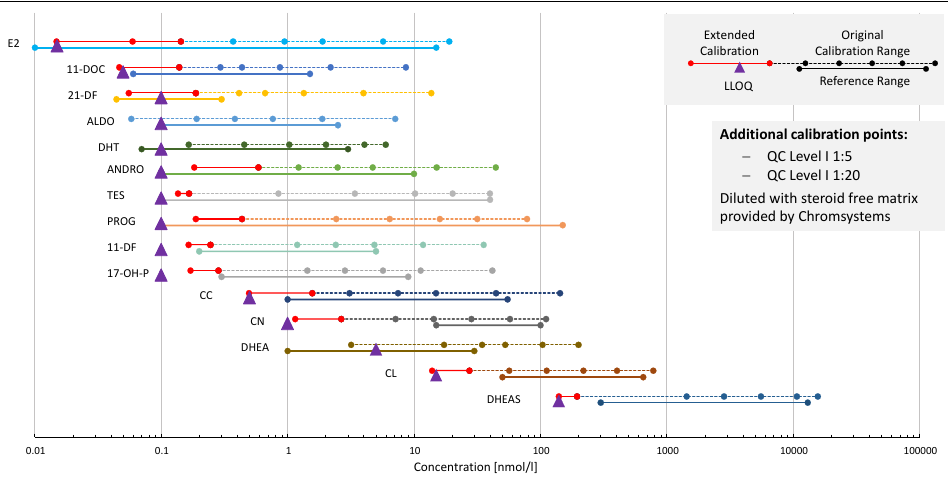
Figure 2. Overview of the concentrations of LLOQs, calibration ranges (original and extended calibration), and human biological reference intervals of 11-deoxycorticosterone (11-DOC), 11-deoxycortisol (11-DF), 17-OH-progesterone (17P), 21-deoxycortisol (21-DF), androstenedione (ANDRO), aldosterone (ALDO), corticosterone (CC), cortisol (CL), cortisone (CN), dehydroepiandrosterone (DHEA), dehydroepiandrosterone sulfate (DHEAS), dihydrotestosterone (DHT), estradiol (E2), progesterone (PROG), and testosterone (TES) on a decadic logarithmic scale. Reference ranges (full lines) and original calibration ranges (dashed lines) as provided by the calibrator manufacturer are color-coded for each analyte. Dots indicate the individual calibrator sample. Extensions of calibration ranges to meet the requirements of the reference range are presented in red, red dots mark the additional calibration samples derived from quality control materials. Violet triangles mark the set lower limit of quantification.